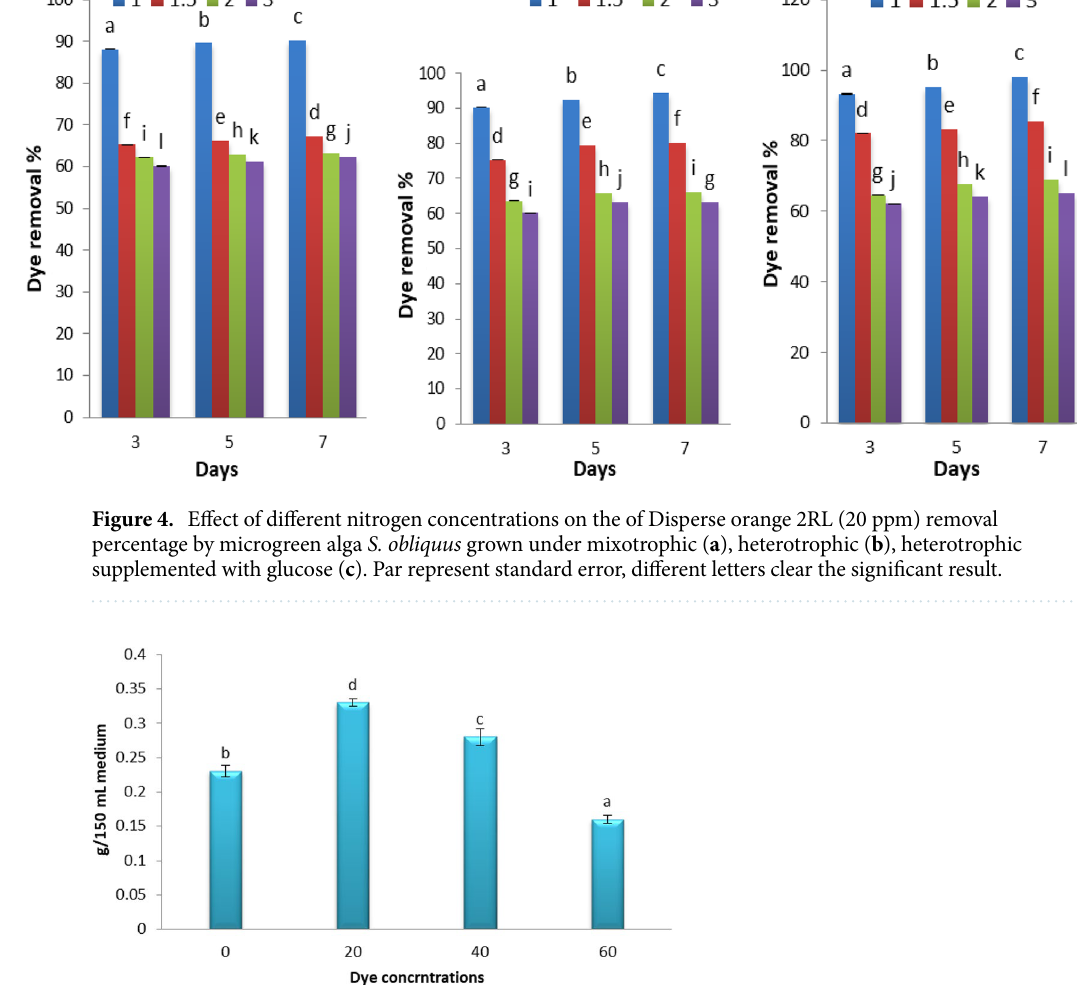
Figure 5. Effect of different dye concentrations of the of Disperse orange 2RL on alga ( S. obliquus ) dry weight with mixotrophic conditions, pH 7 and KNO 3 1.5 g/L. Par represent standard error, different letters clear the significant